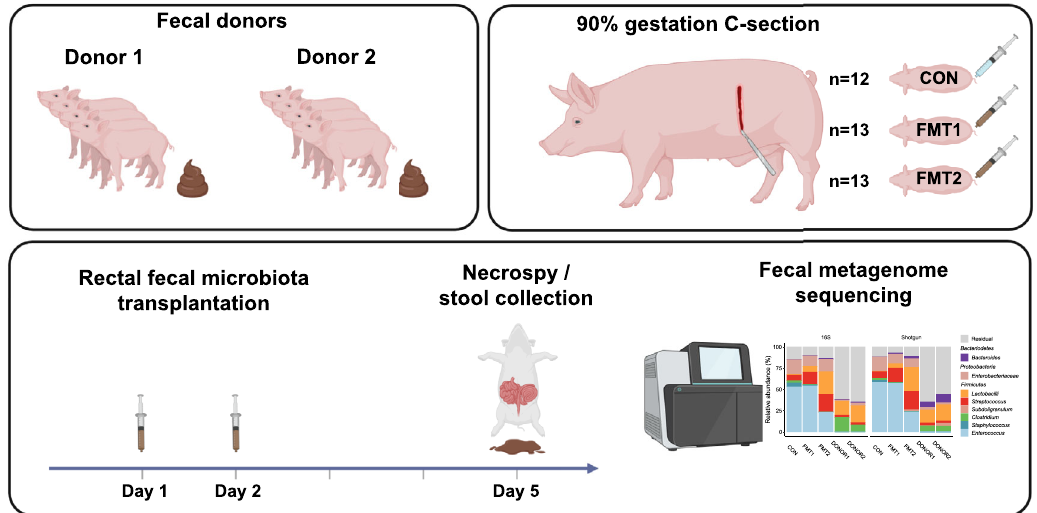
Fig. 1 Study design. Fecal donor material was obtained from 2 different groups of term piglets (Donor 1 and 2) and rectally administered to preterm piglets born at 90% gestational age on one and two days of life. The preterm piglets were euthanized on day 5 of life. Respectively n = 13, 13, 12 for FMT1, FMT2 and CON. FMT1 rectal FMT with Donor 1, FMT2 rectal FMT with Donor 2, CON rectal FMT with sterile saline as control. The completed graphic was created with BioRender.com in an academic license (Supplementary